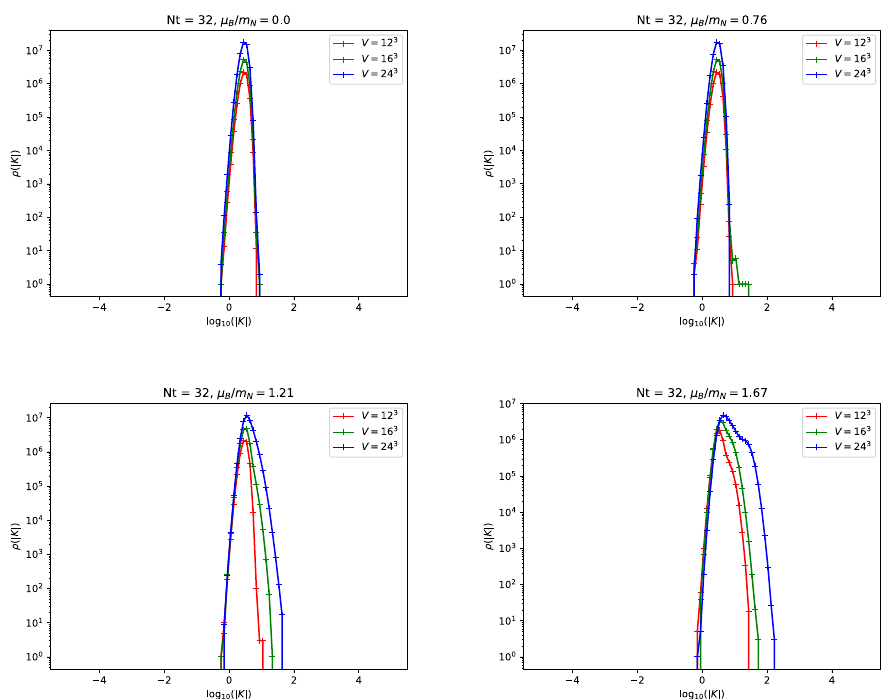
Figure 1: Histograms of the Langevin force K for N t = 32 ( T = 103 MeV) for three volumes and di ff erent values of the baryon chemical potential μ B in units of the nucleon